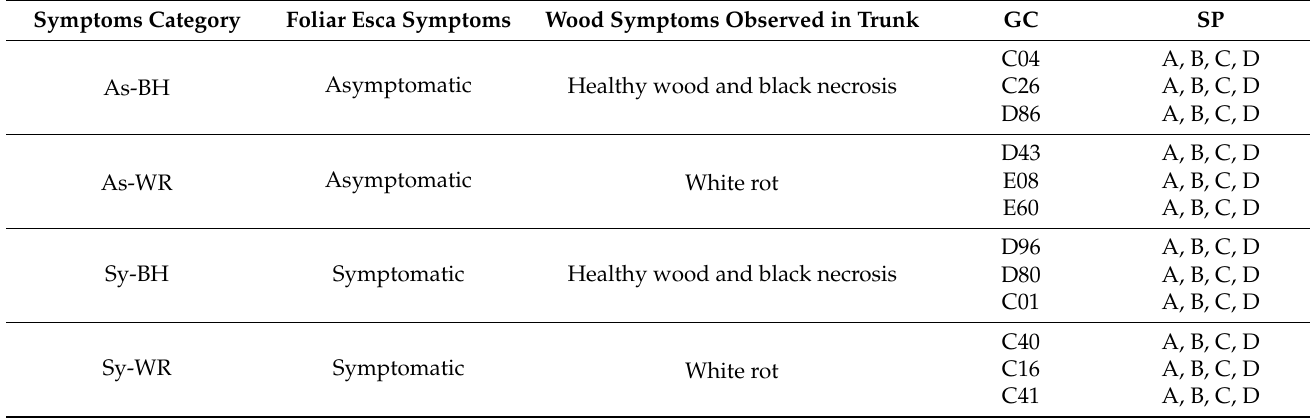
Table 3. List of the four categories of symptoms related to foliar symptoms manifestation (As vs. Sy) and type of wood symptoms observed in the trunk (presence of white rot, WR, vs. presence of black necrosis with healthy wood, BH) compared in this work. List of grapevines ( n = 12) and list of wood core sampling points (48). GC: Grapevine code; SP: Sampling